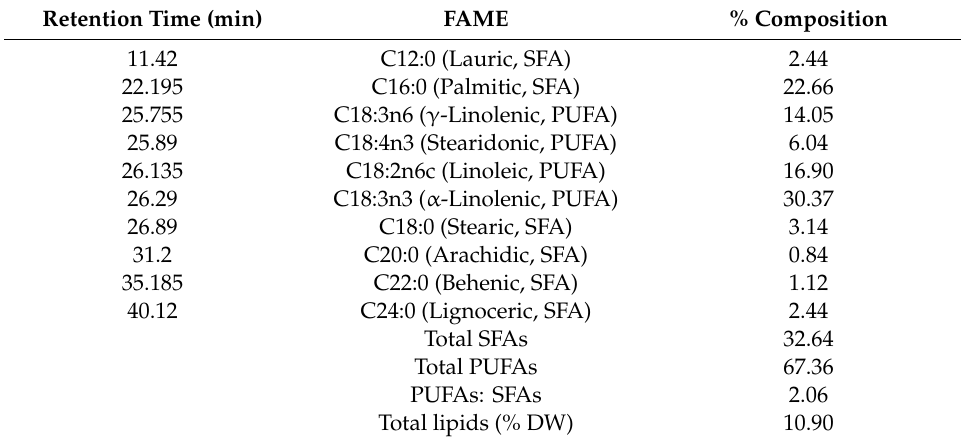
Table 5. Fatty acid composition in the leaf tissues of Mertensia maritima .